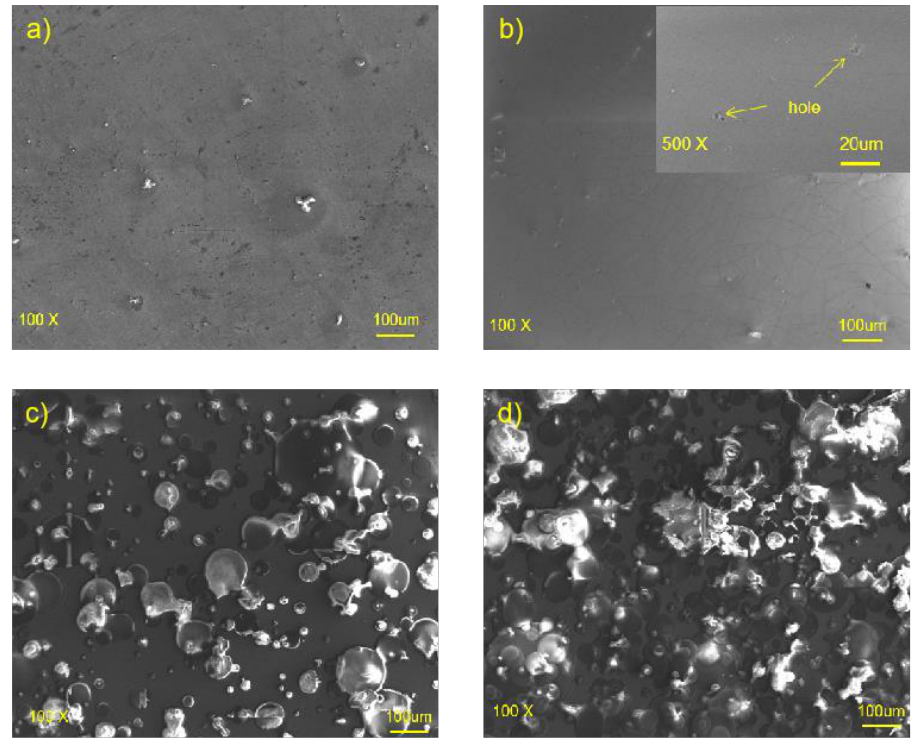
Figure 3. SEM images of ( a ) bare Mg alloy, ( b ) HF-Mg and ( c ) PLLA (5)-HF-Mg, ( d ) PLLA (10)-HF-Mg.